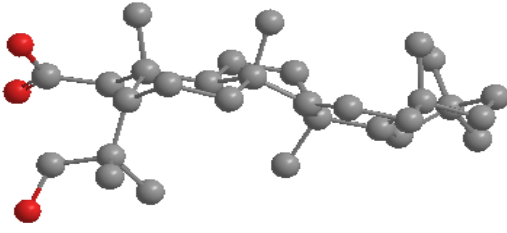
Figure 3. Ball and Stick minimized energy model for 5